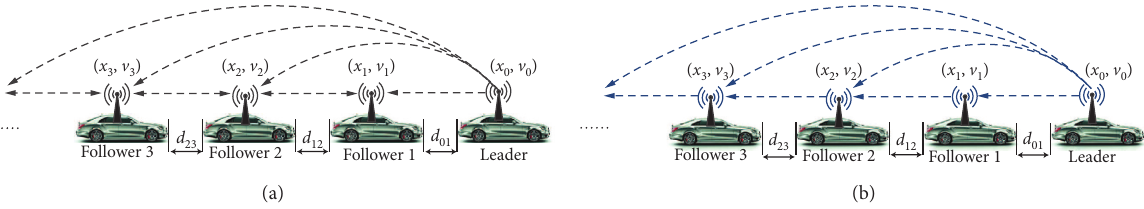
Figure 1: Typical interconnected information flow for vehicular platoons. (a) Undirected topology. (b) Directed